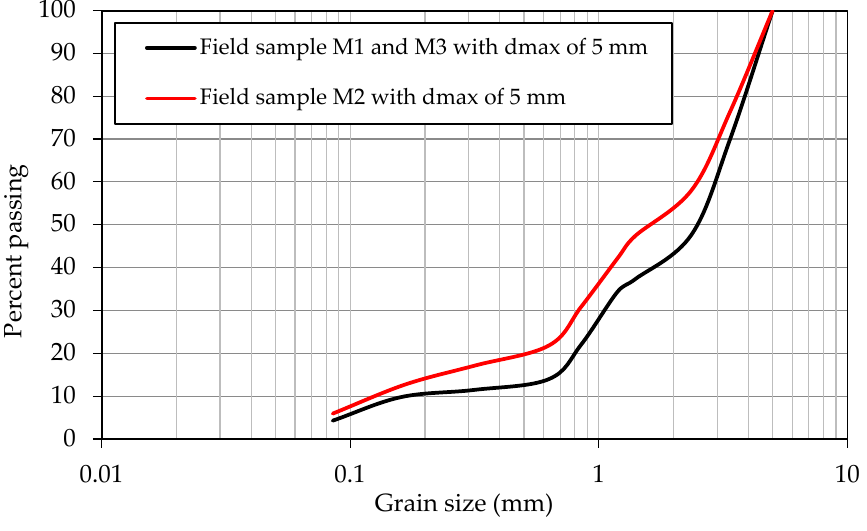
Figure 2. PSDCs of field samples M1, M2 and M3.